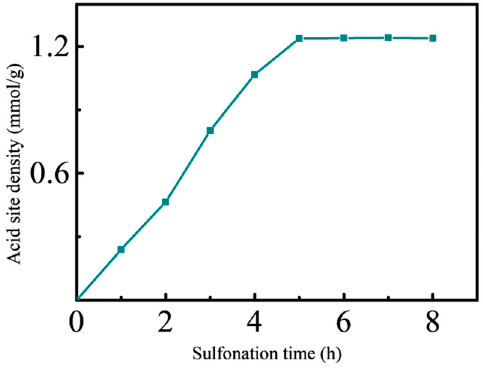
Figure 3. Effect of sulfonation time on acid density.